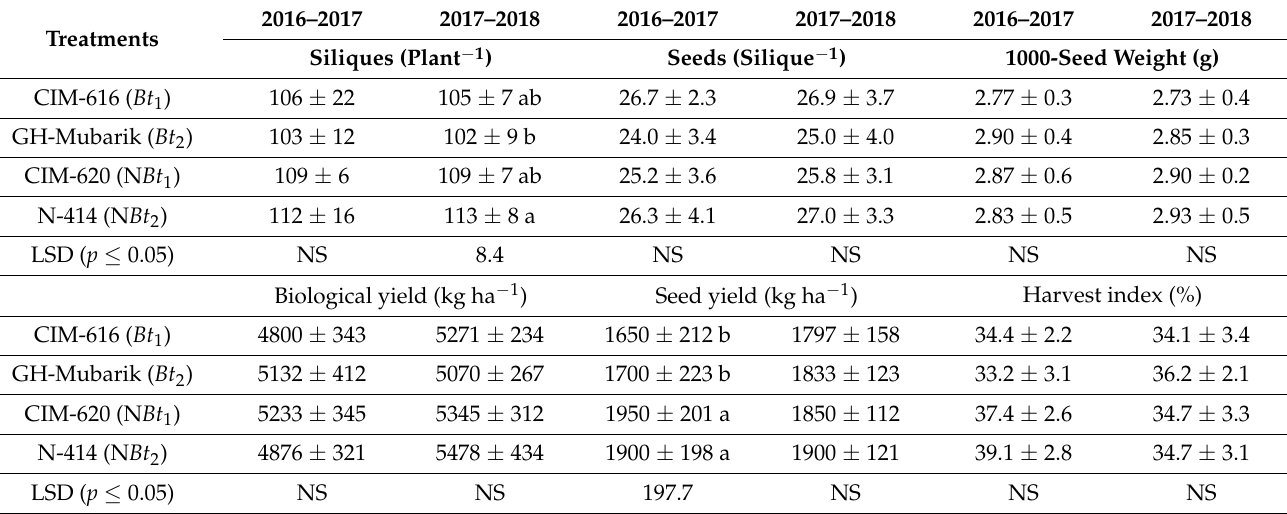
Table 7. cotton genotypes.